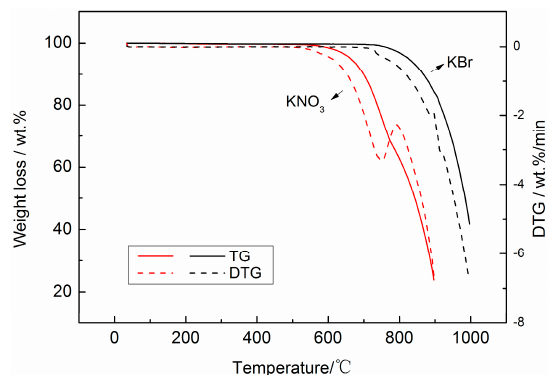
Figure 4. TG ‐ DTG analysis for KNO 3 and KBr.